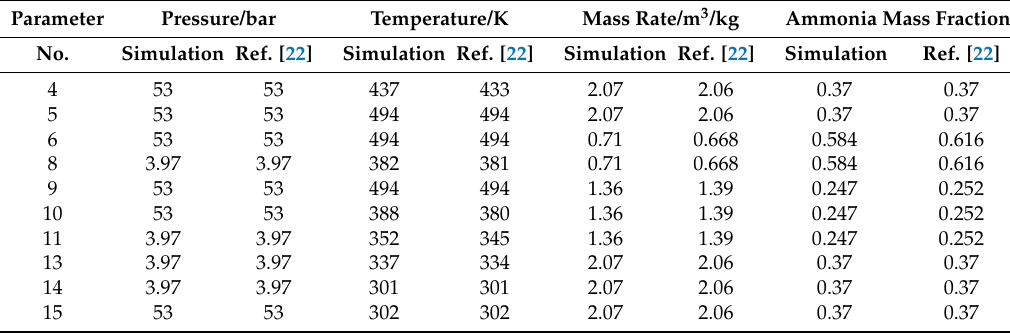
Table 2. Validation of the numerical model with the published data.